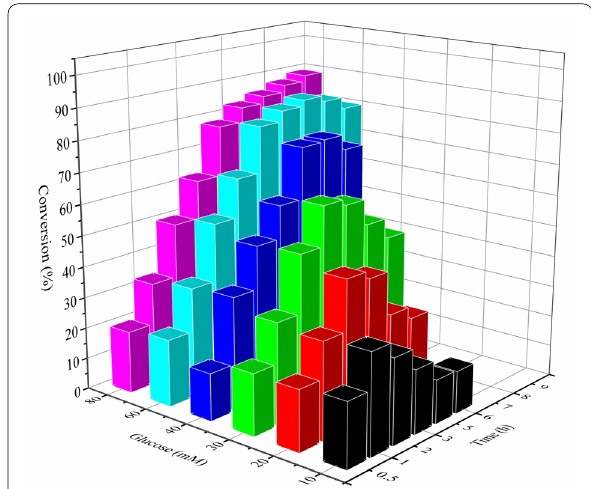
Fig. 1 Effect of glucose concentrations on asymmetric reduction of 3A5AF catalyzed by recombinant E.coli _GDH_ScCR cells. Reaction